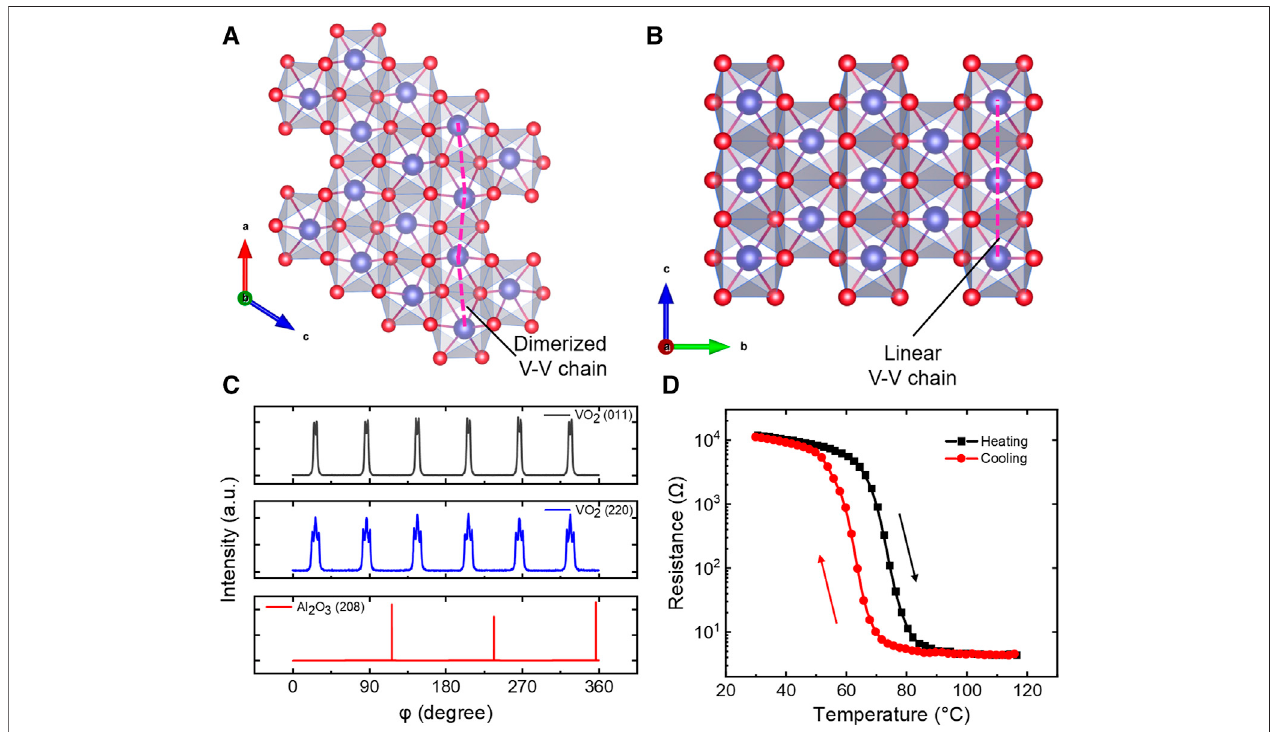
FIGURE1| Schematiccrystalstructuresof (A) monoclinicVO 2 (M1)and (B) rutileVO 2 (R),wheretheblueandredspheresrepresentvanadiumandoxygenatoms, respectively. (C) Full-range X-ray diffraction (XRD) φ -scans of the (011) and (220) planes of the VO 2 (M1) thin fi lm relative to the (208) peak of the substrate at room temperature. (D) Resistance ( R ) of a typical VO 2 thin fi lm grown on c -plane Al 2 O 3 substrate as a function of temperature ( T